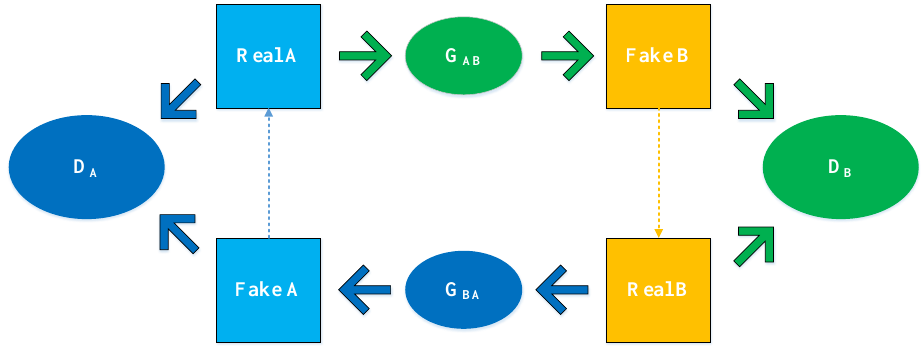
Figure 2. Overview of the contrastive domain